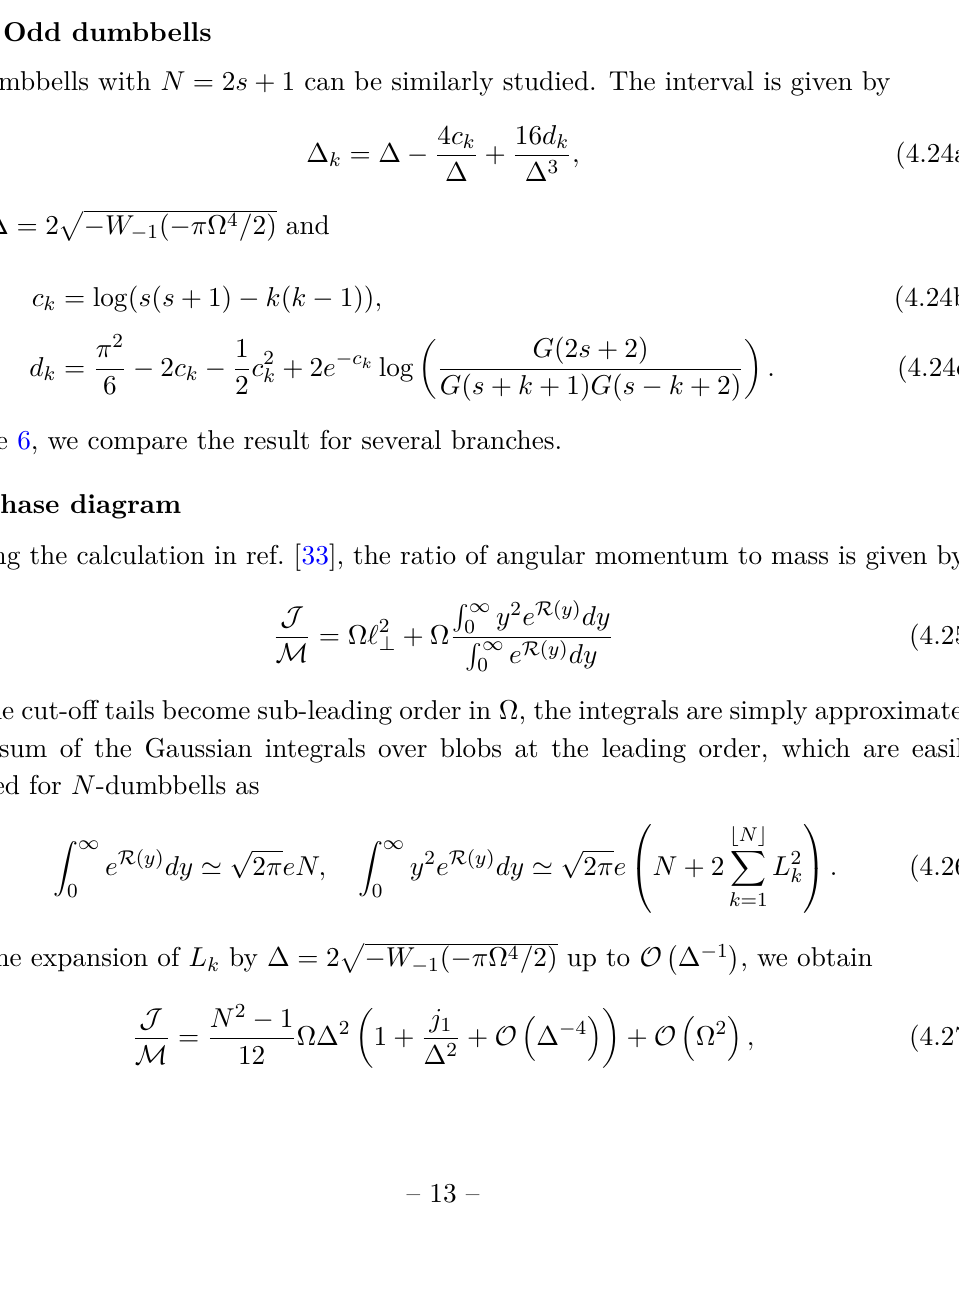
Figure 6 . The normalized separations are compared with the numerical result (solid curves). The dashed curves are the result up to O used in ref.